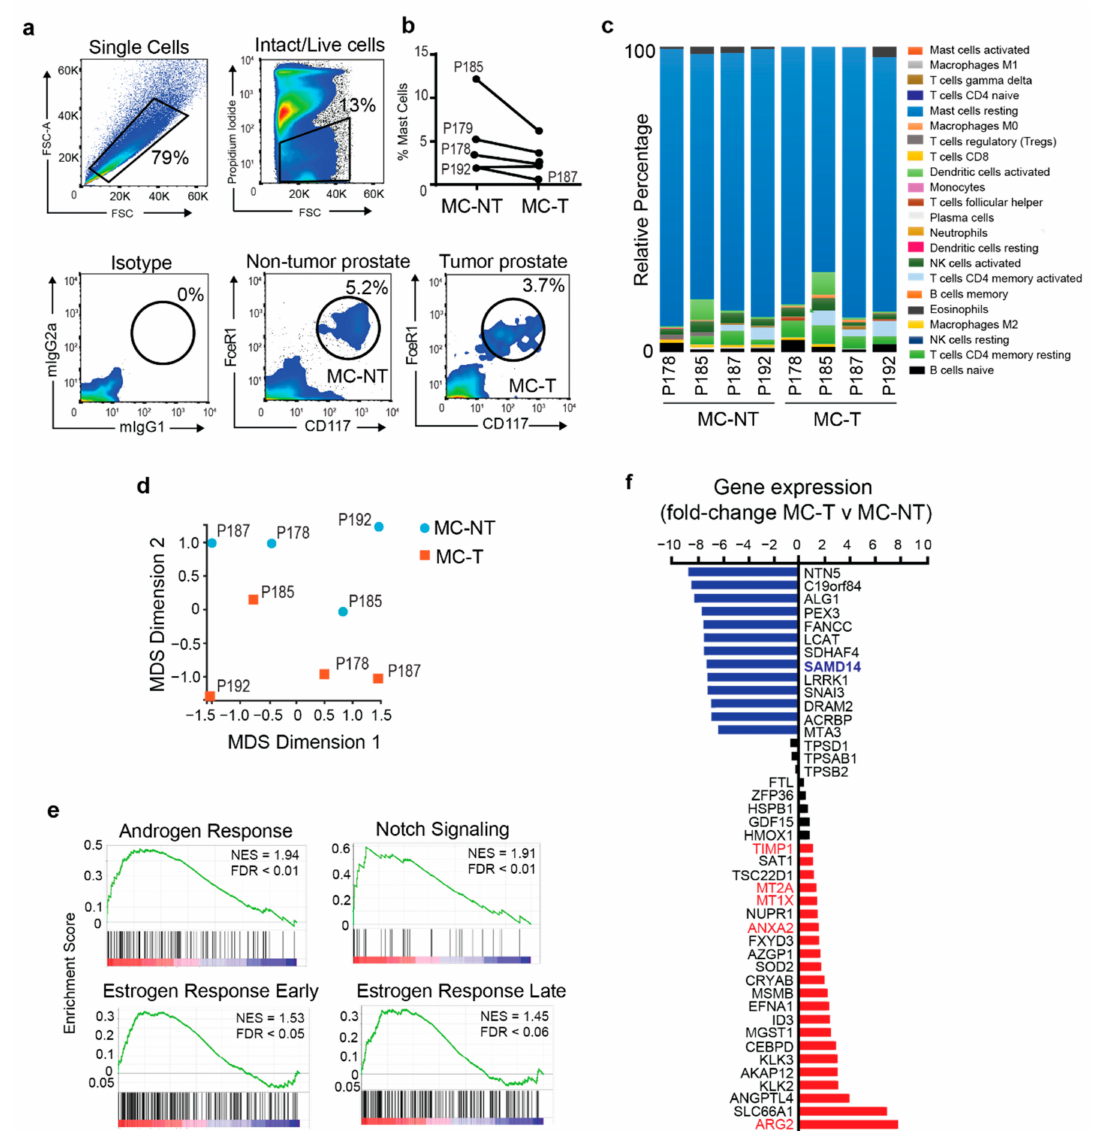
Figure 1. Isolation and transcriptomic profiling of primary mast cells from human prostate tissue ( a ) Flow cytometric plots demonstrate gating strategy for mast cell isolation from primary human radical prostatectomy tissue based on isotype control staining. Plots are representative; n = 5 patients. ( b ) Graph shows the percentage of viable mast cells isolated from paired tumor (MC-T) and non-tumor (MC-NT) patient prostate tissue from 5 localized prostate cancer patients. ( c ) CIBERSORT analysis of primary mast cell RNAseq dataset shows that relative percentage of genes associated with immune subtypes. ( d ) MDS (multidimensional scaling) plot of MC-T (orange squares) and MC-NT (blue circles) patient samples based on gene expression. ( e ) GSEA analysis of MC-T and MC-NT transcriptomes using 50 hallmark gene sets (MSigDB) demonstrates enriched biological pathways in MC-T relative to MC-NT. Normalized enrichment score (NES); false discovery rate (FDR). ( f ) Differential gene expression analysis shows fold-change of genes decreased in MC-T (blue bars) and increased in MC-T (Red bars) based on false discovery rate (FDR) < 0.1 and fold-change (FC) > 2 relative to MC-NT; grey bars indicate FC <